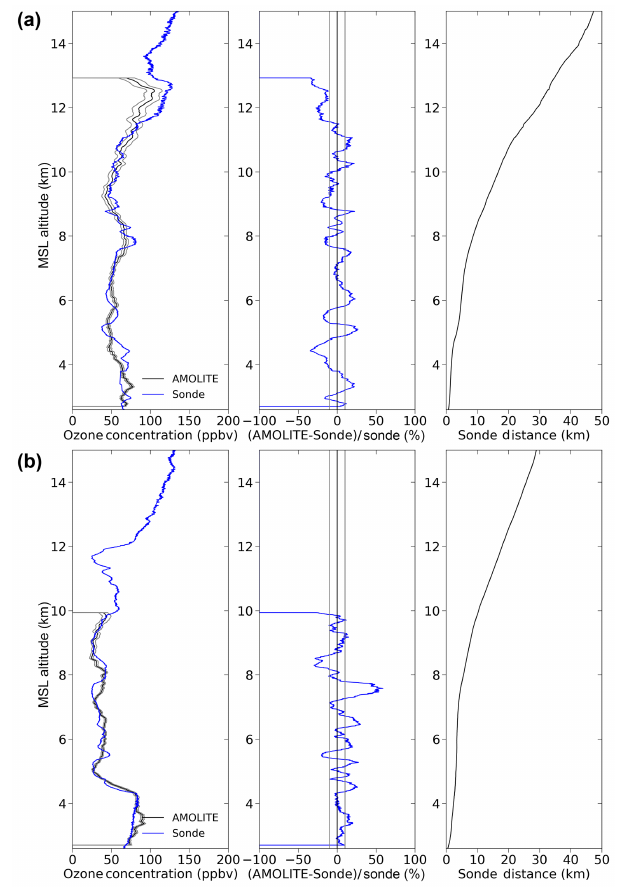
Figure 5. Three-panel plots showing AMOLITE ozone profile against the sonde profile, the percentage difference between the two profiles and the horizontal sonde distance from the launch site for (a) 04:01UTC on 10 August and (b) 21:03UTC on 16 August. Lo- cal time is UTC − 7h.